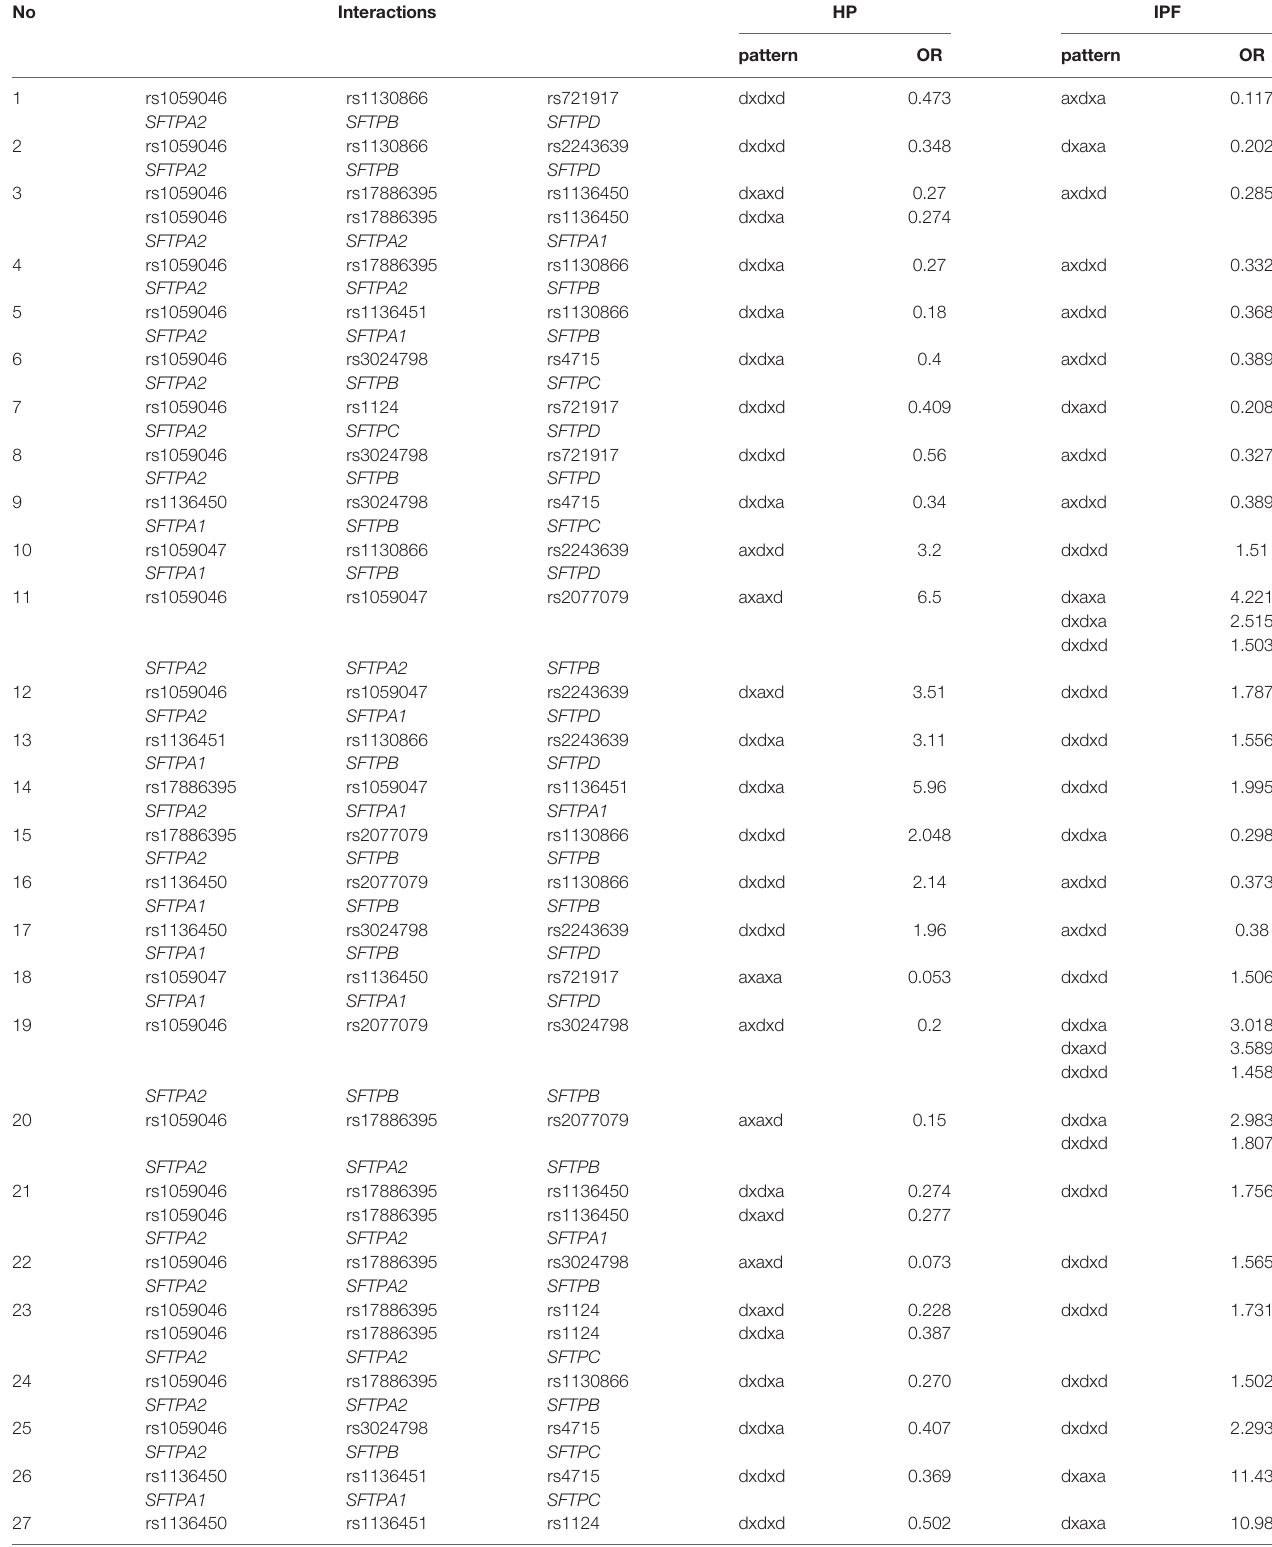
TABLE 8 | Interactions with the same SNPs and different effect pattern in IPF and HP